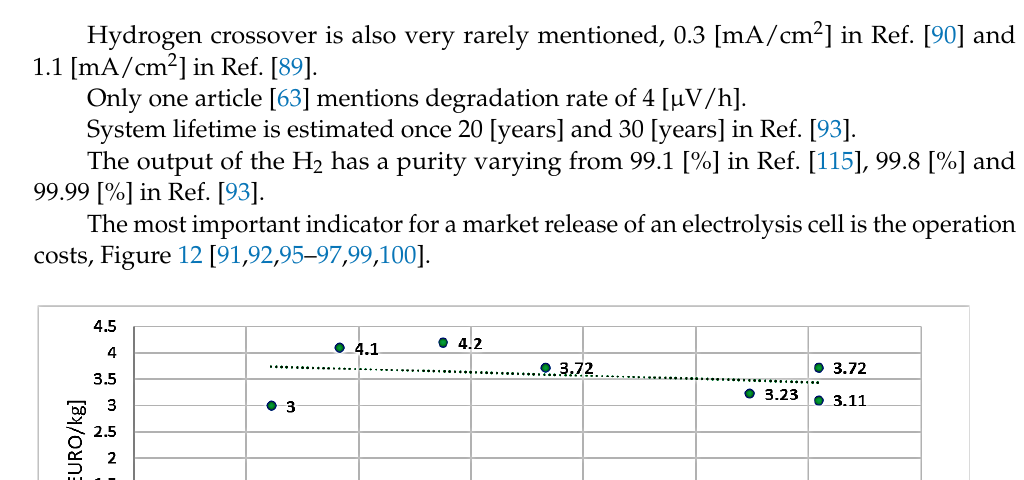
Figure 12. Operation cost for H 2 production.